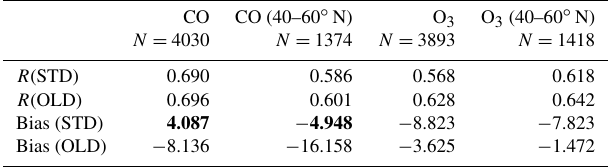
Table 6. Model comparison with Mirai cruises: no outlier filter is applied. N is the available data for each calculation. Correlation coefficient ( R , no unit) and biases (ppbv) in the STD run are shown as bold if better than those in the OLD